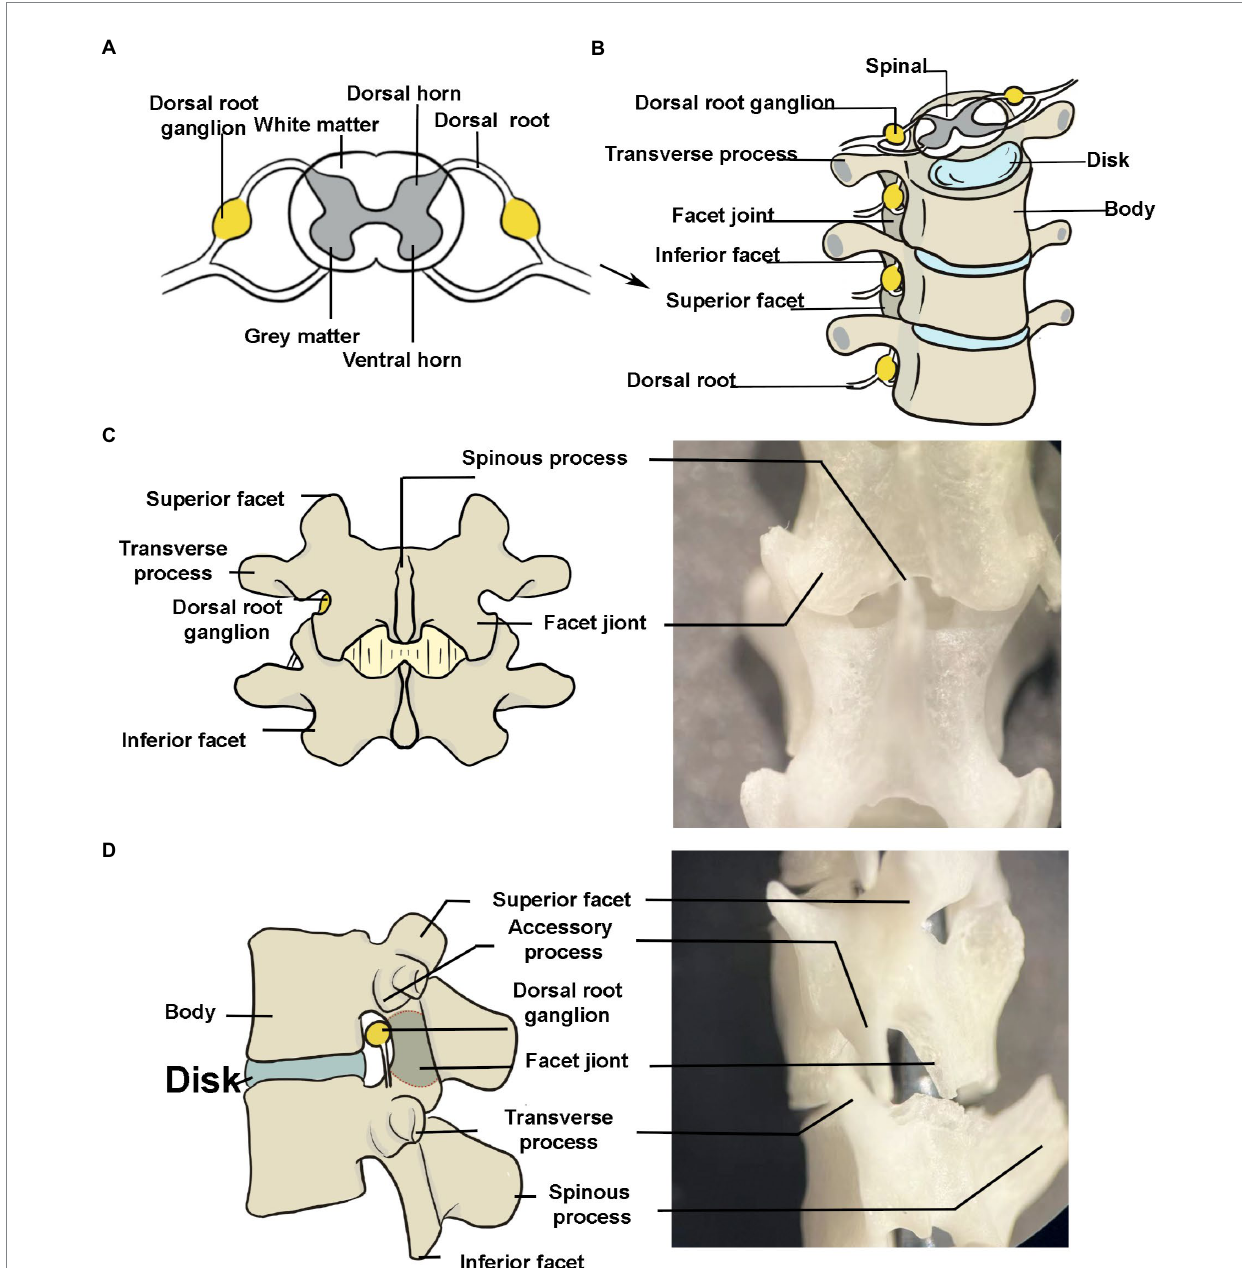
FIGURE 1 Peripheral anatomy of the dorsal root ganglion (DRG). (A) The DRG is a cluster of sensory neuron cell bodies located in the dorsal roots of the spine. The schematic portrays a transverse section of the spine. (B) The bony structures surrounding the DRG (lumbar segments, anterior view). The transverse process has been exaggerated to make it easier to understand. (C,D) Posterior and left side view of spine. The DRG is seen in the foramina. It is difficult to see the transverse processes in the posterior view due to the short transverse process in mice. The image depicts a large one for better